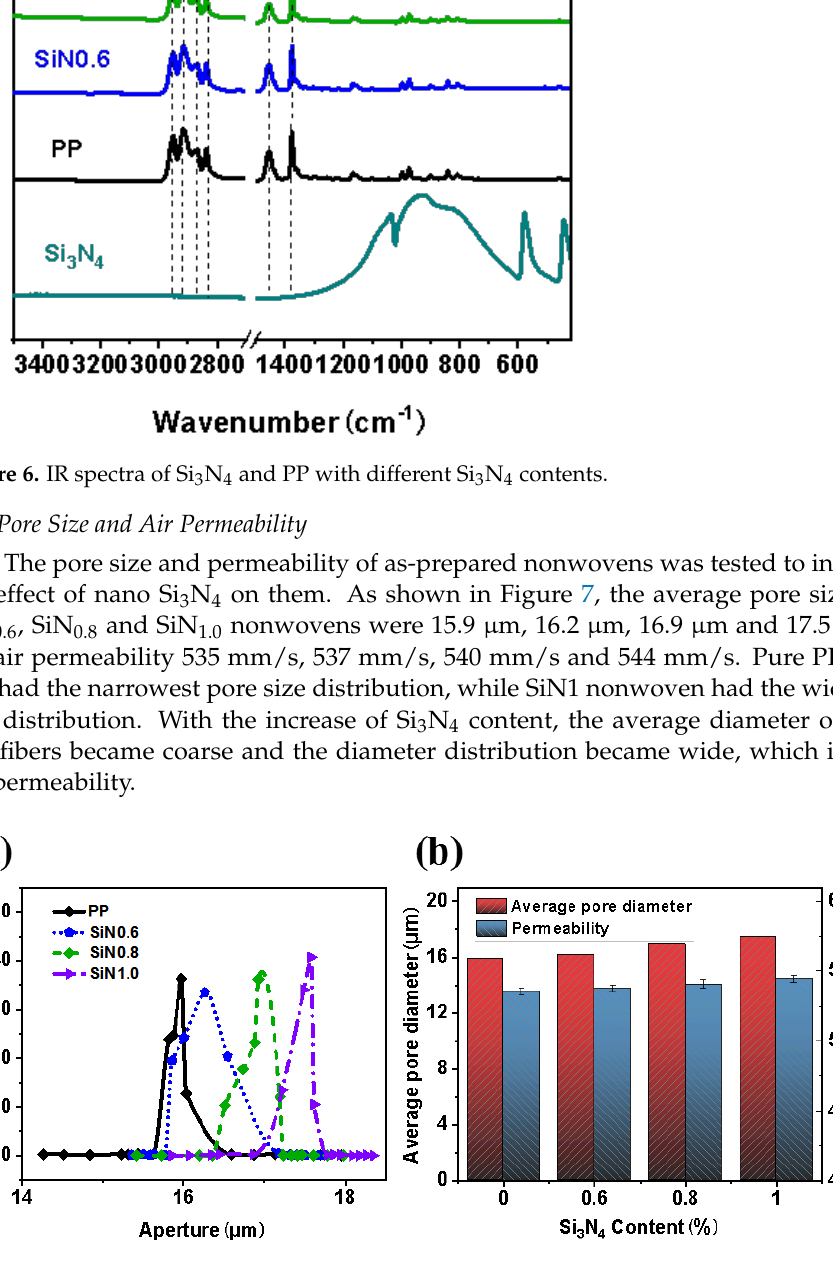
Figure 7. Pore size and permeability of nonwovens with different Si 3 N 4 content: ( a ) pore size distribution and ( b ) average pore size and permeability.